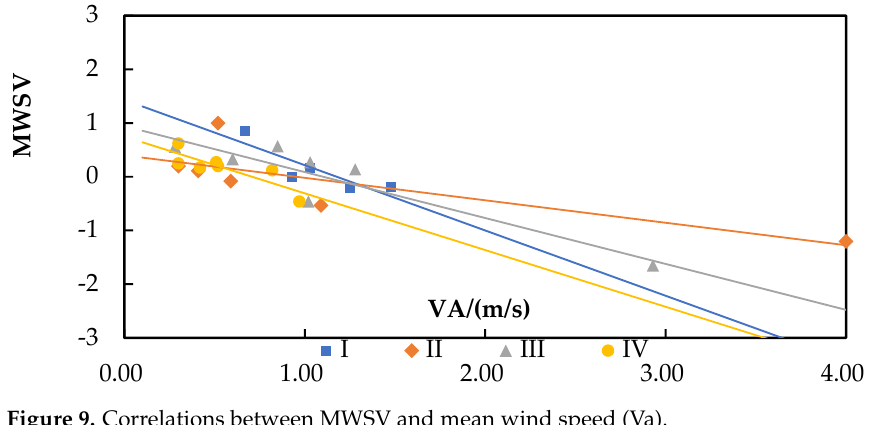
Figure 9. Correlations between MWSV and mean wind speed (Va).